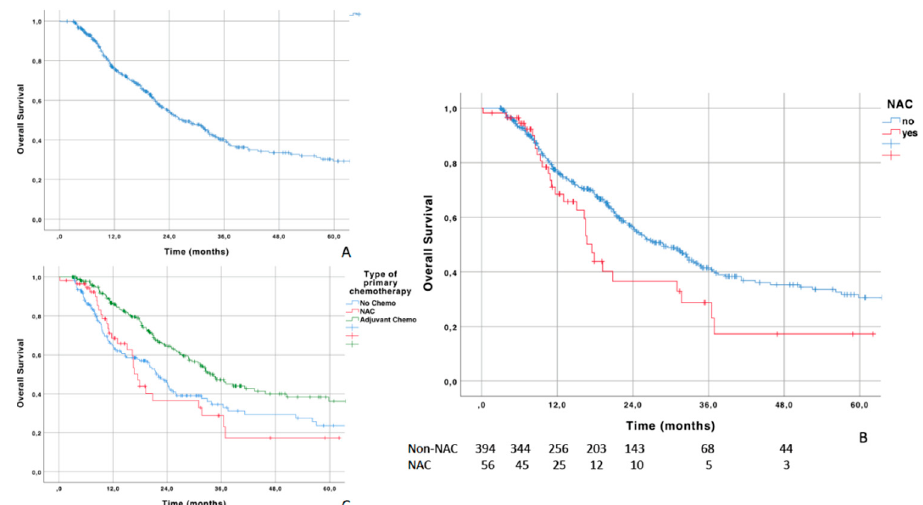
Figure 1. ( A ) Overall survival (OS) curve in the overall cohort; ( B ) OS stratified by the use of neoadjuvant chemotherapy (NAC); ( C ) OS stratified by the type of primary chemotherapy: neoadjuvant chemotherapy (NAC), adjuvant chemotherapy (AC), no chemotherapy.